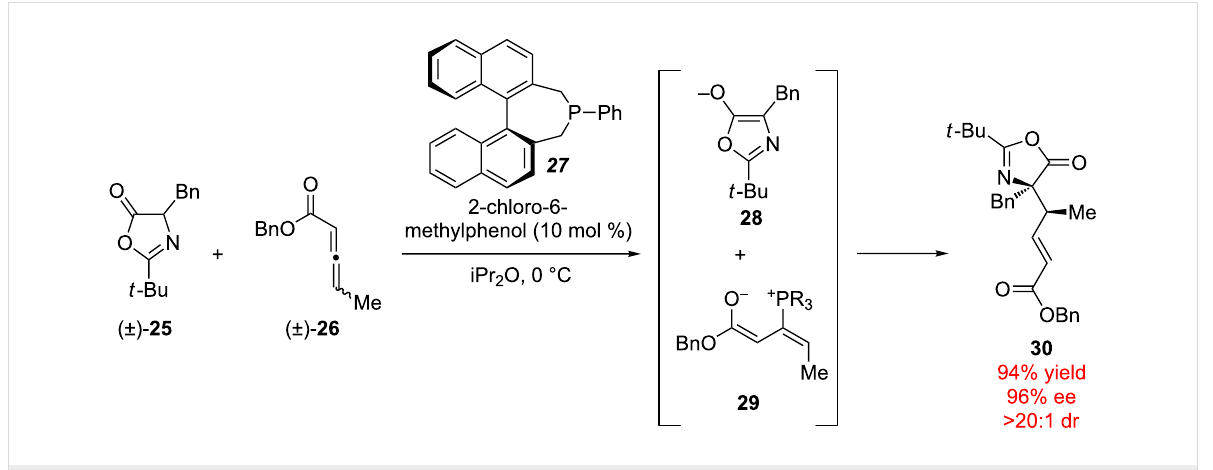
Figure 4. Similar to type I, reactions of this type involve a kinetic resolution of the racemic starting material. However, in this case the two enantiomers undergo separate modes of reac- tivity, each leading to an identical product. Reactions of this type are variants of the powerful parallel kinetic resolution (PKR) strategy [32,33], owing to the two parallel